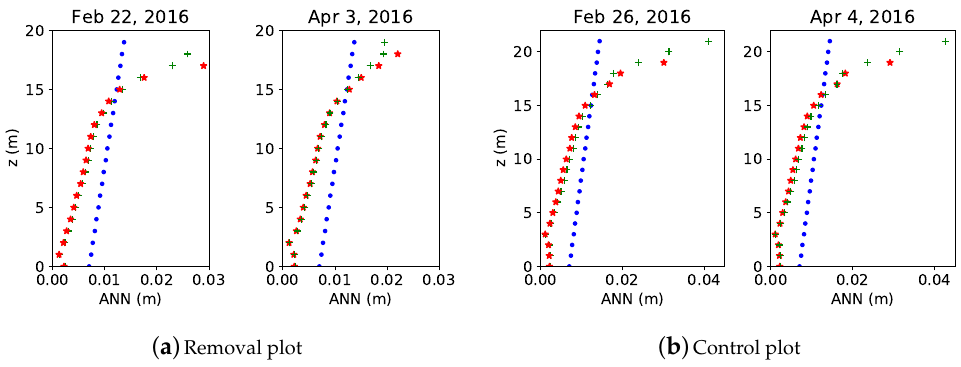
Figure 10. Comparison of multiple return vs. first return vertically resolved average nearest neighbor distance (ANN(z)) for pre- and post-cut TLS data of the removal plot ( a ) and bi-temporal data of the control plot ( b ). ( • Laser beam diameter, (cid:63) First return and + Multiple